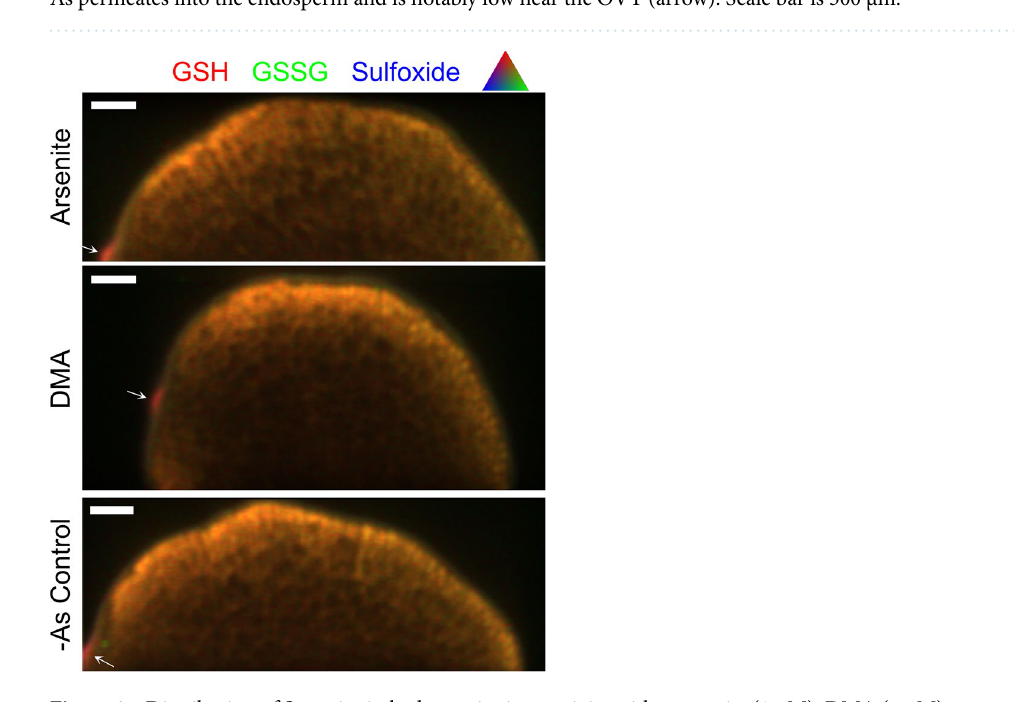
Figure 2. Distribution of S species in hydroponic rice receiving either arsenite (1 uM), DMA (5 uM), or no As. Arrows show the location of the OVT. All S species are scaled to the same maximum value to illustrate relative concentrations. Scale bars are 200